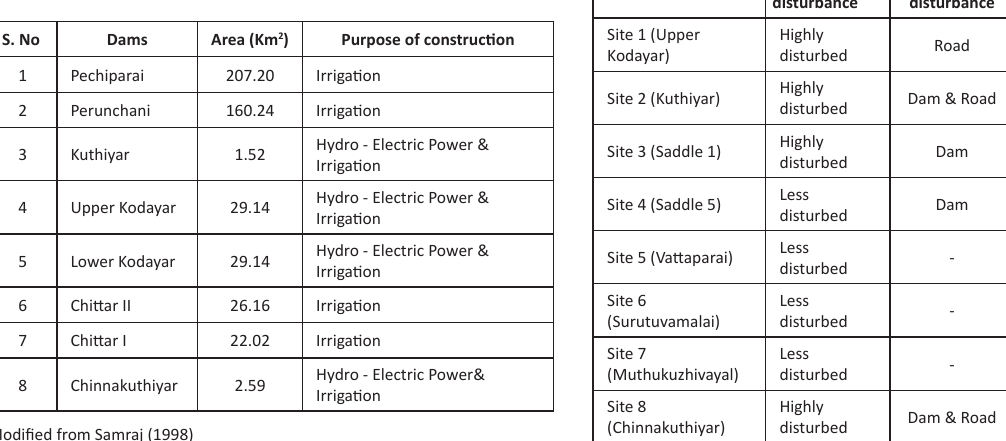
Table 2. Major reservoirs in Western Ghats of Kanyakumari District S. No